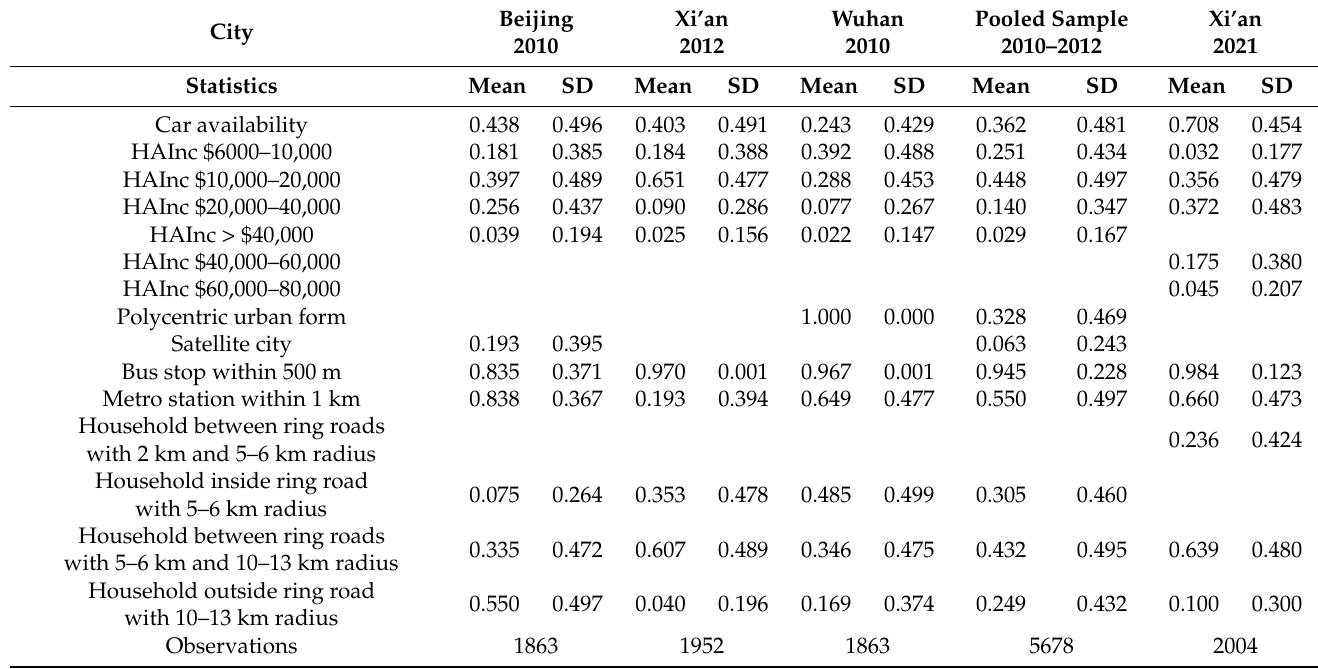
Table 2. Statistics of the regressors in the BMA